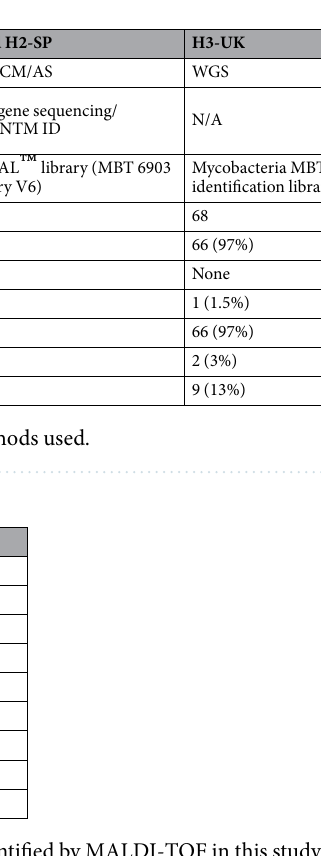
Table 2. Range of species and number of isolates identified by MALDI-TOF in this